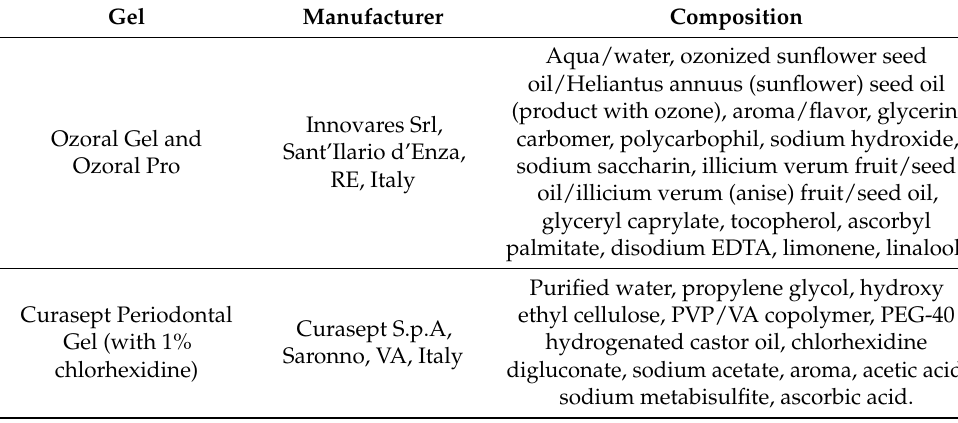
Table 2. Materials tested in the